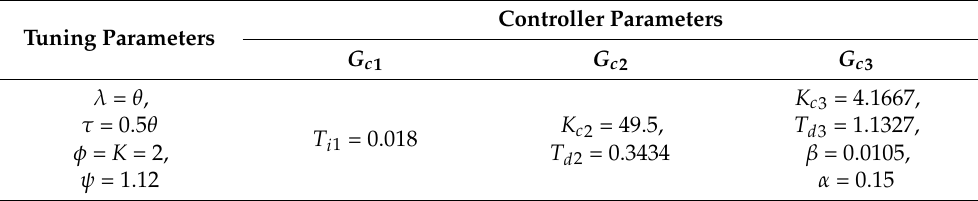
Table 2. Controller parameters obtained using the method proposed in Example